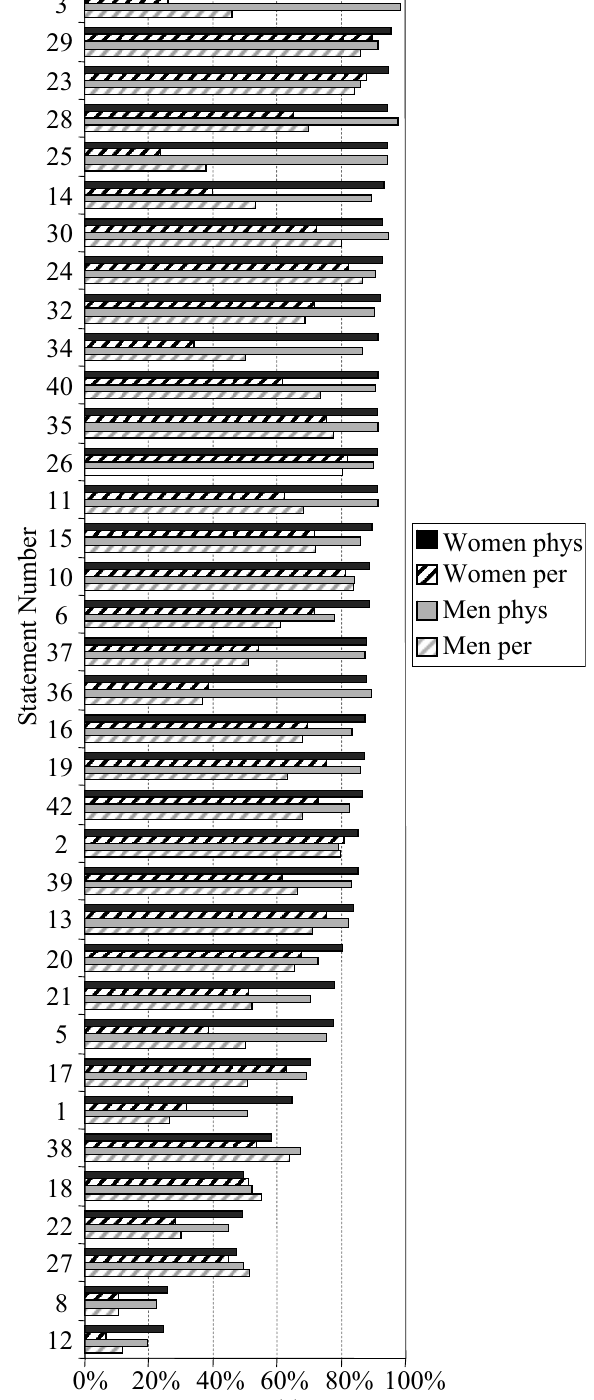
FIG. 8. Individual “personal” and “physicist” statement scores (cid:1) pre scores (cid:2) by gender for the Physics I-Alg course sorted by wom- en’s “physicist” score.